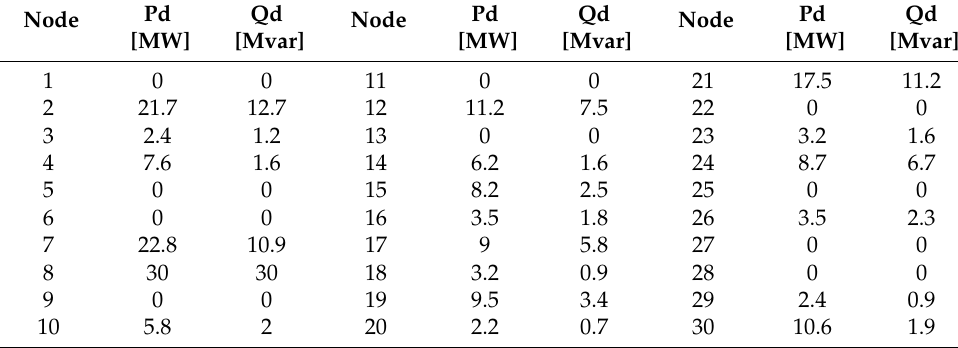
Table 2. 30 bus bar system loads